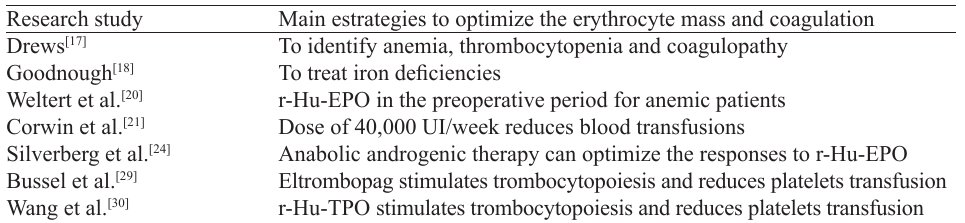
Table 1. Main estrategies to optimize the erythrocyte mass and coagulation